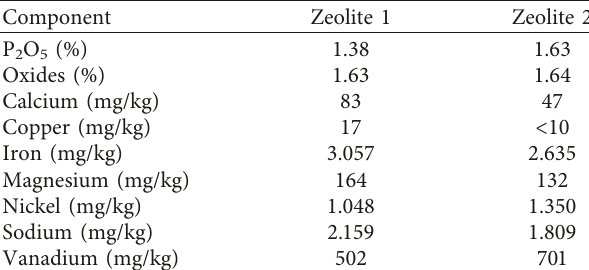
Table 2: Composition of subproduct